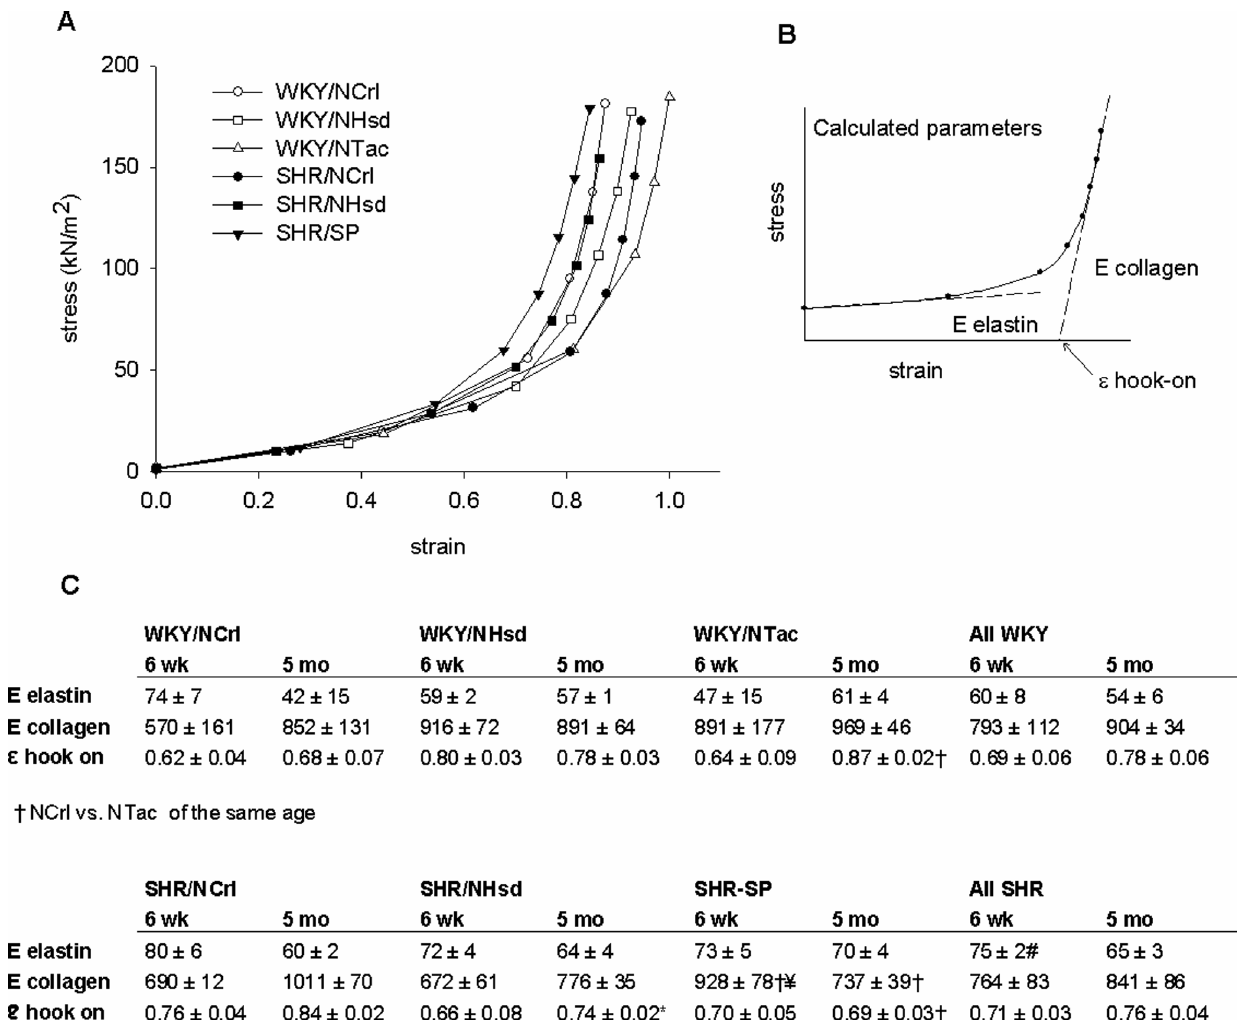
Figure 3. Vascular stiffness. To assess vascular stiffness, stress-strain relationships were calculated from diameter, wall thickness and pressure. Panel A shows that SHR vessels are not necessarily stiffer than WKY vessels. As illustrated in panel B, data were fitted to a three parameter equation to estimate the elasticity of elastin (E elastin, in kN/m2), the elasticity of collagen (E collagen, in kN/m2) and the level of strain were collagen is proposed to hook-on ( e hook-on). This revealed that the vessels from the SHR/SP are the most left in the stress-strain relationship because of an early hook-on of collagen (panel C). Each group consists of n $ 5 animals, where 2 vessels from each animal were measured and averaged.